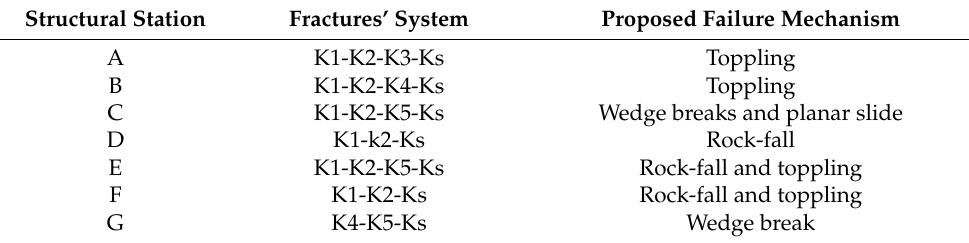
The intersection between fracture systems and bedding allows us to hypothesize different failure mechanisms along the Coroglio-Trentaremi sea cliff, which are listed in Table 4. To synthesize, structural analysis of the sea cliff points out a high susceptibility to landsliding of several tuffaceous blocks by means of rock-fall and toppling. Systems of fractures are 5 to 7 m spaced and intercept the bedding, thus isolating large rocky dihedrons and pinnacles whose volume may exceed some hundreds of cubic meters (Figure 10). This volume estimation is confirmed by measurements of landslide niches’ dimensions, that may reach values of 500 m 3 , and of large blocks within the landslide bodies. Table 4. Failure mechanism proposed for each structural